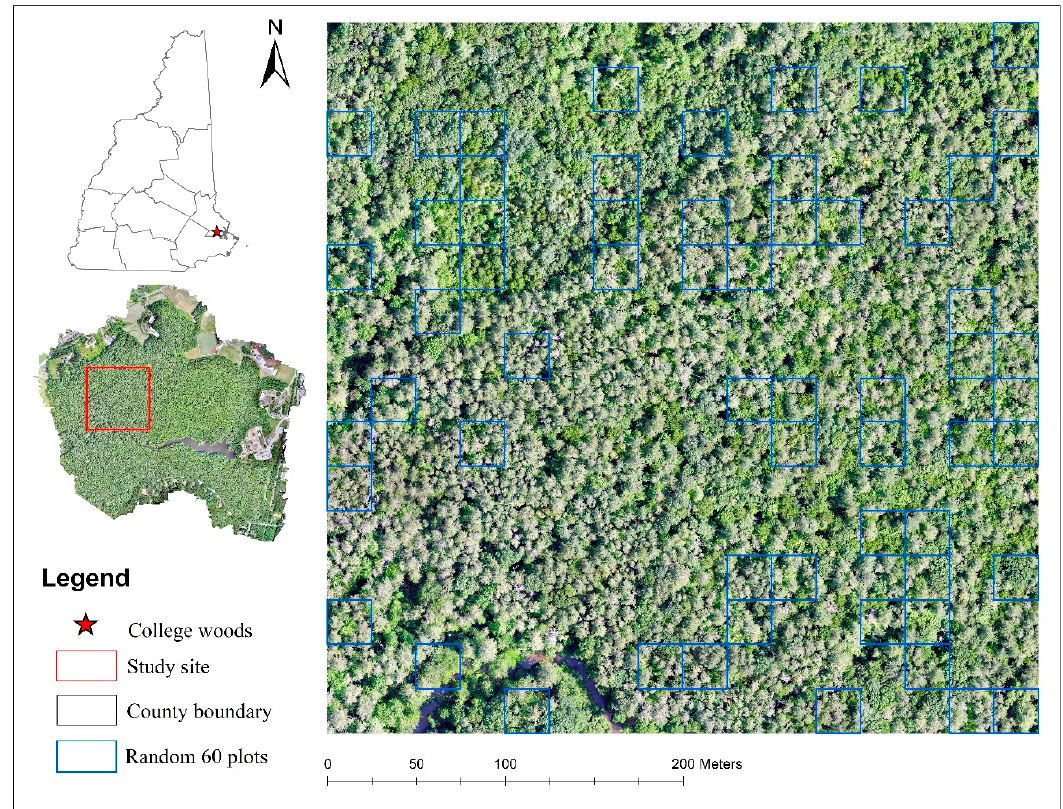
Figure 2. Study site at College Woods, New Hampshire, U.S.A.